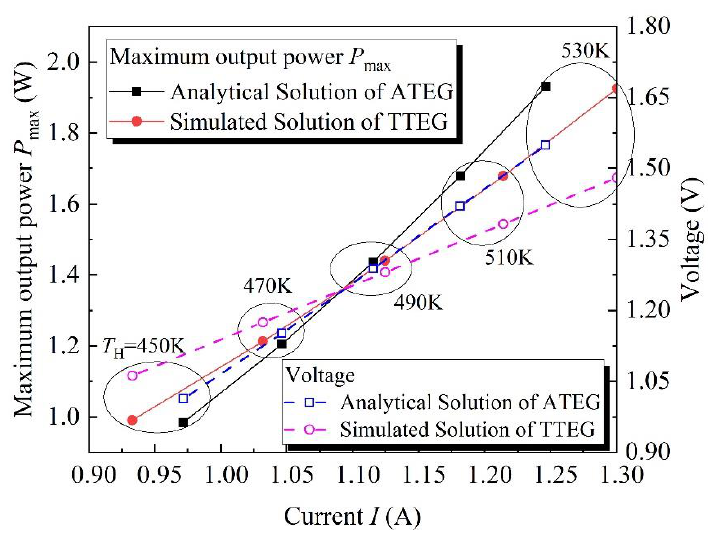
Figure 7. P - I and V - I curves under different temperature gradients when T C = 300 K.